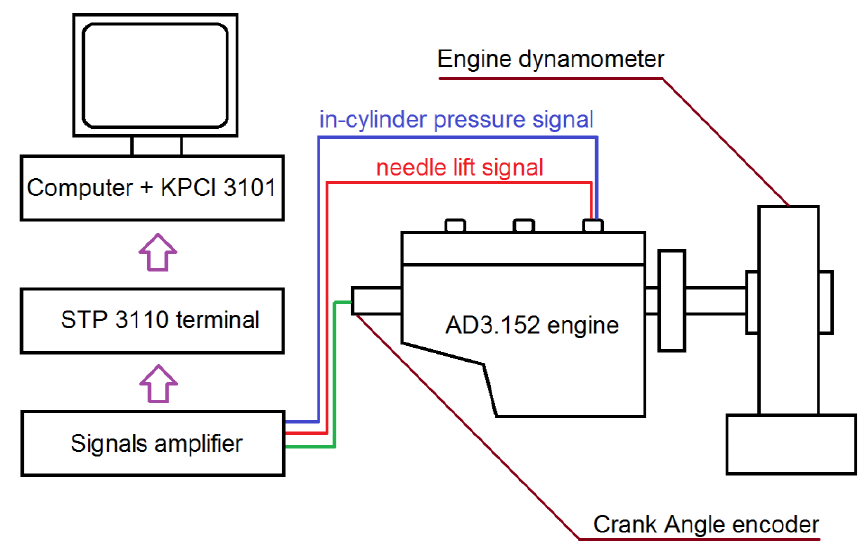
Figure 1. Test stand equipped with the AD3.152 engine. Table 1. Selected data of the AD3.152 engine. Developed from [15,42,43].